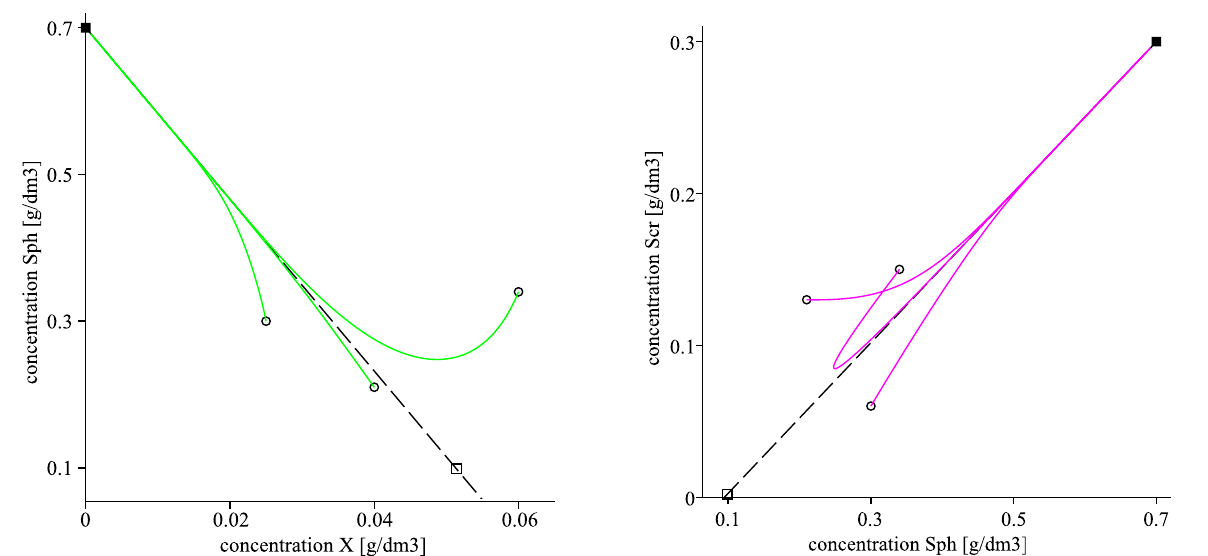
Figure 7. D = 0.095. Projections of the trajectories in the ( X , S ph ) -phase plane ( left ) and in the ( S ph , S cr ) -phase plane ( right ) with three different initial points, denoted by circles. The corresponding components of E 0 are marked by solid boxes, of E 2 are denoted by boxes. The dash lines present projections of the invariant planes S ph + k ph X = S 0 ( right